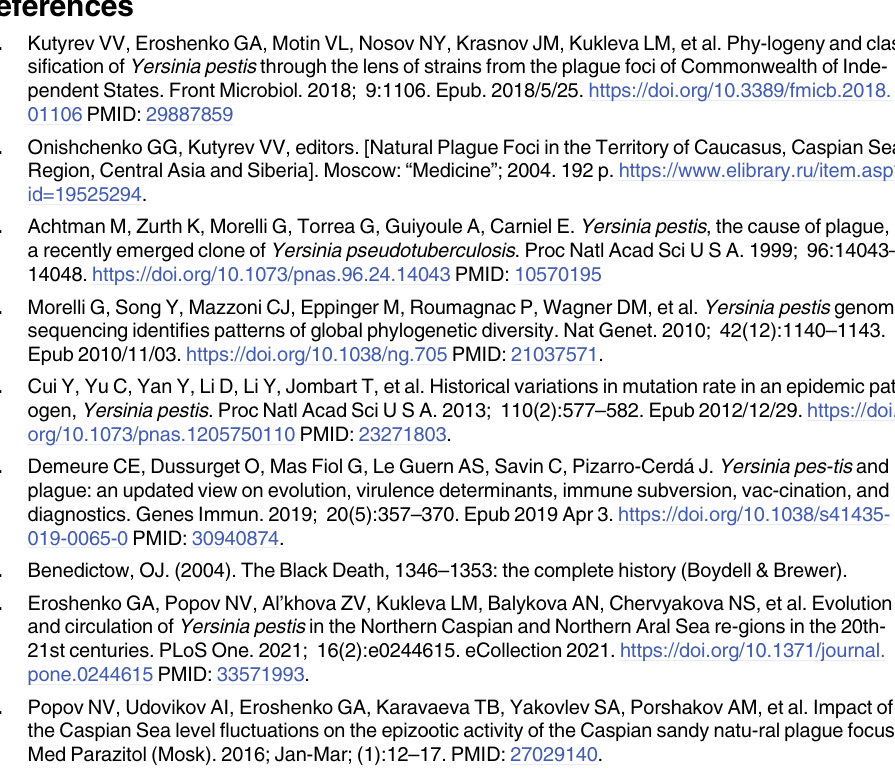
S5 Fig. Map of seaports and roads in the Caspian and Caucasus regions. © https:// kakdobratsyado.ru/country/kazahstan/goroda-kazahstana/aktau-kazahstan. (TIF) Author